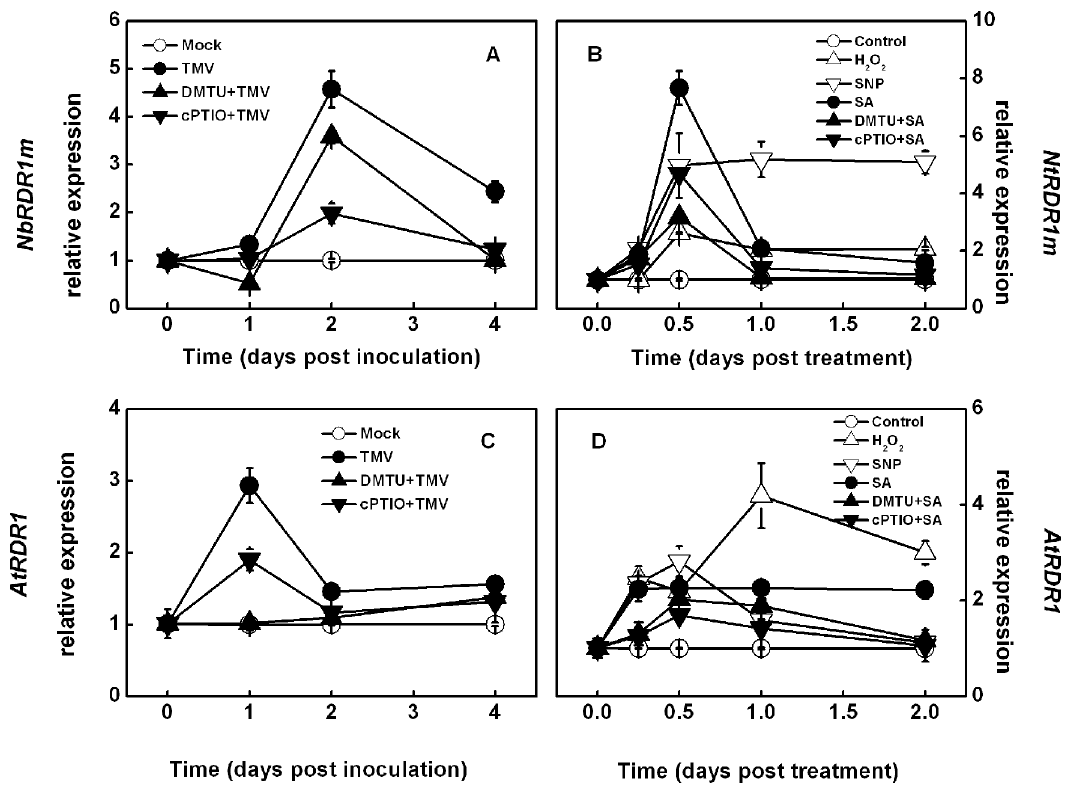
Figure 3. Effects of TMV infection, SA, and different chemical pretreatment on transcripts of NbRDR1m and AtRDR1 . A and C . Changes in TMV-induced NbRDR1m ( A ) and AtRDR1 ( C ) transcript levels over time in non-inoculated upper leaves induced by scavengers of hydrogen peroxide (H 2 O 2 ) and nitric oxide (NO). The non-inoculated upper leaves were subjected to DMTU (H 2 O 2 scavenger) or cPTIO (NO scavenger) pretreatment 12 hours before TMV inoculation. B and D . Changes in SA-induced NbRDR1m ( B ) and AtRDR1 ( D ) transcript levels over time induced by exogenous H 2 O 2 , NO, and their scavengers. The results are expressed as the mean 6 SD, n = 4.